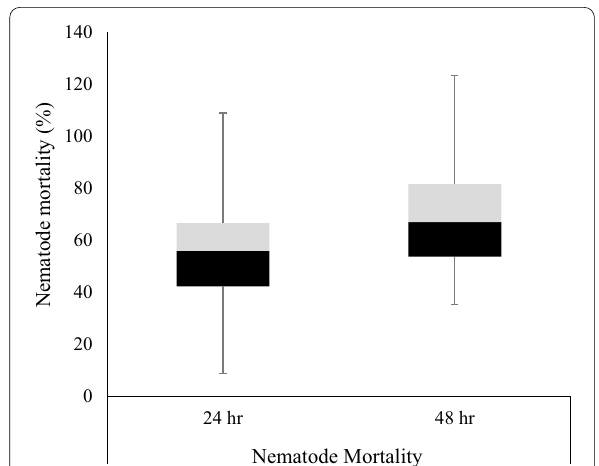
Fig. 3 Box‑and‑Whisker plot for nematicidal activity. It shows median (middle line in the box), upper quartile (end of black box), lower quartile (end of gray box), maximum and minimum